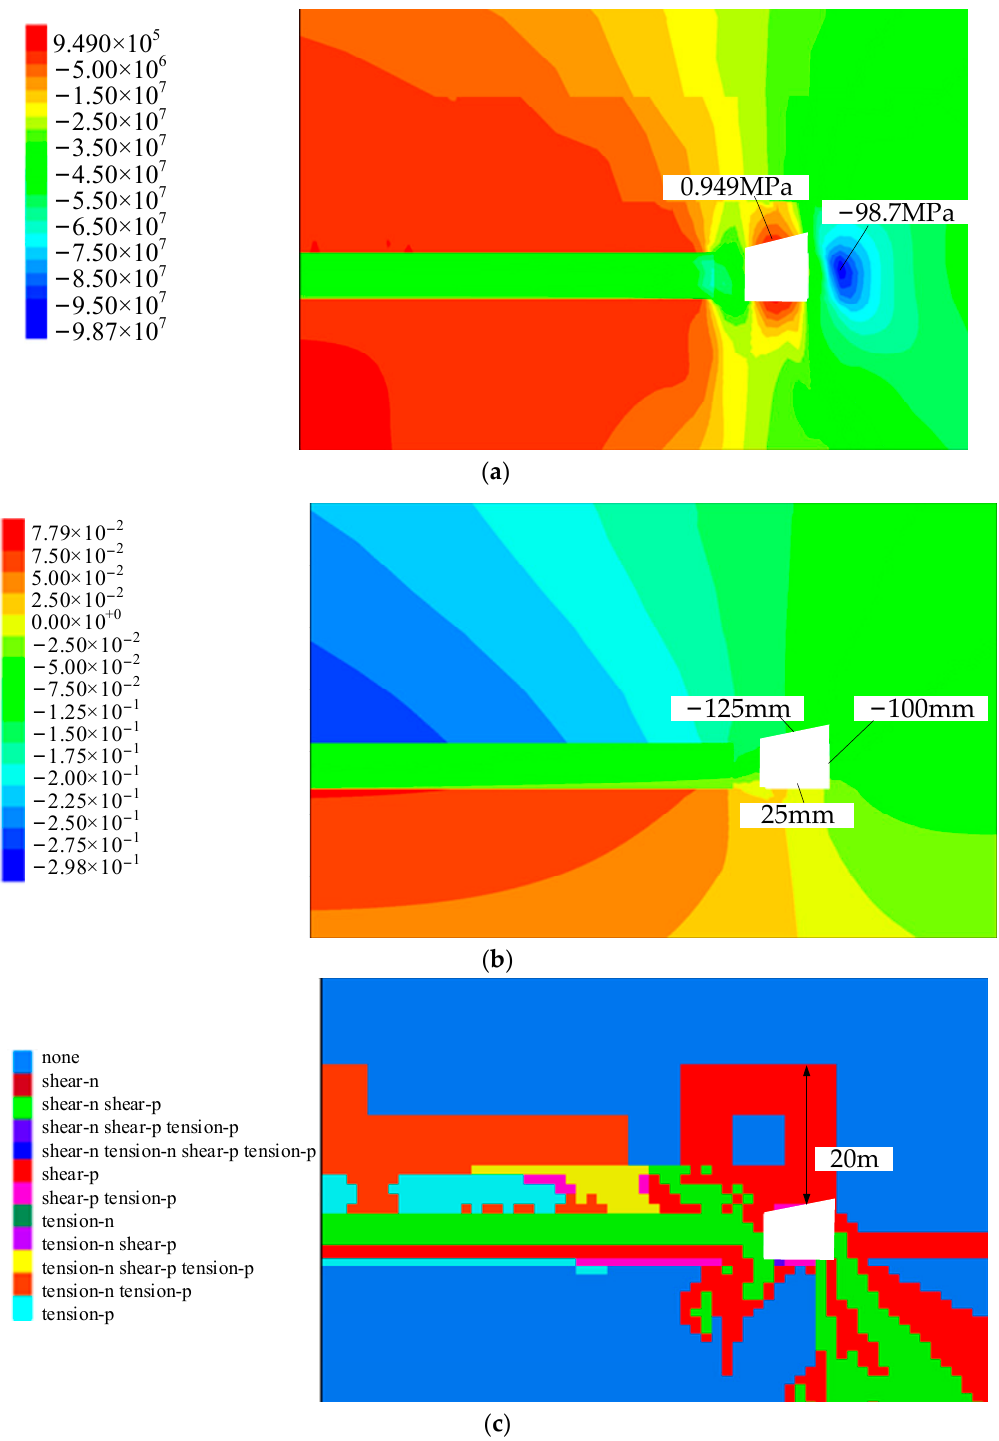
Figure 3. Simulation results of once support, ( a ) vertical stress distribution diagram, ( b ) vertical displacement distribution map, ( c ) distribution diagram of the plastic zone.